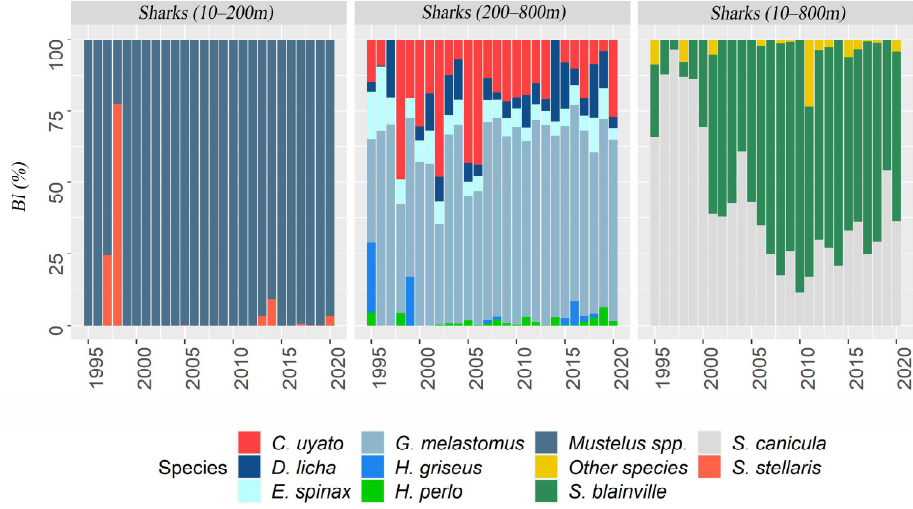
Figure 5. Biomass index (%) of a single shark species among total sharks per depth stratum over the years.